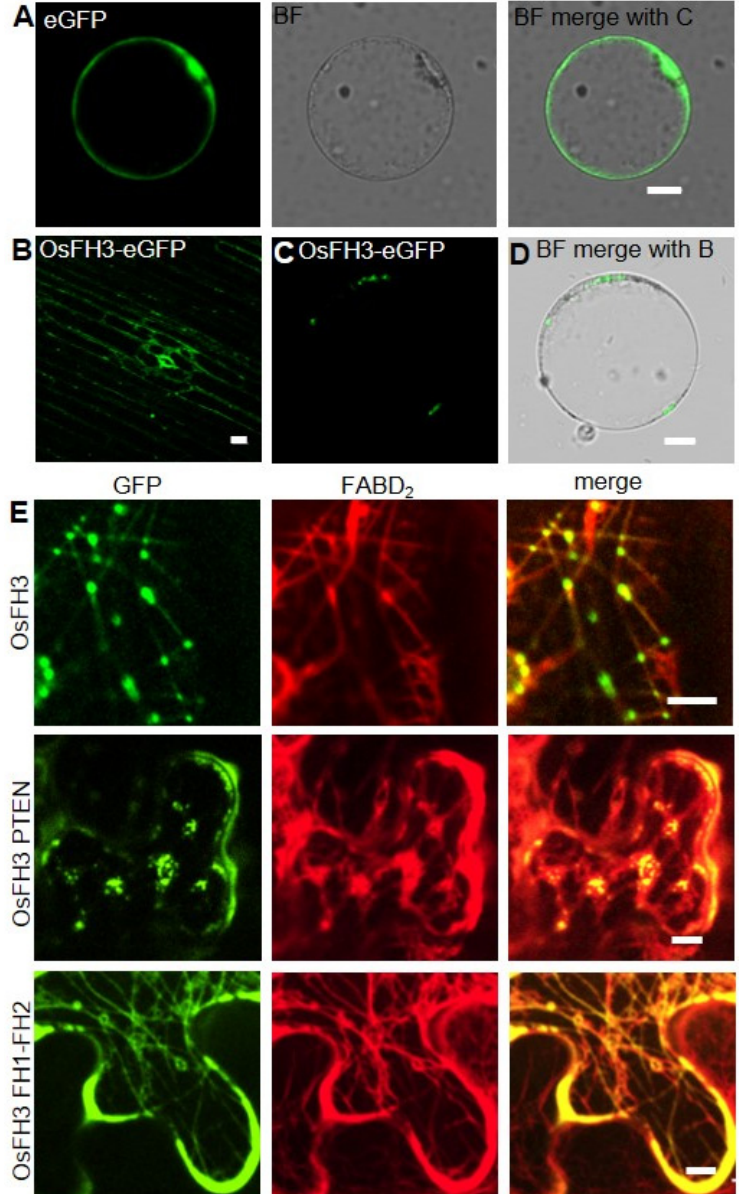
Figure 6. Colocalization of OsFH3 with AF in vivo. ( A ) Contrast, eGFP signals in rice protoplast. Bar= 10 µm. ( B ) OsFH3-eGFP signals in rice coleoptile cells. Bar = 10 µm. ( C , D ) OsFH3-eGFP signals in rice protoplast showing GFP ( B ) and merged bright field (BF) with GFP ( C ) images. Bar = 10 µm. ( E ) Colocalization of OsFH3-eGFP full length protein, OsFH3 PTEN-eGFP and OsFH3 FH1-FH2-eGFP domains with AF marker mScarlet-FABD 2 in tobacco leaves. Bar = 5 µm.